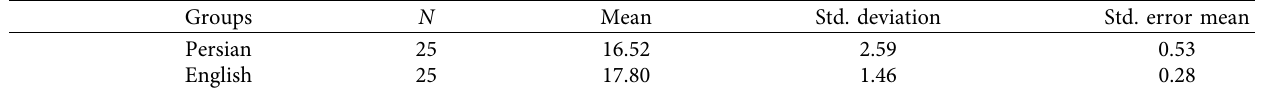
Table 3: Descriptive statistics (posttest of both groups).